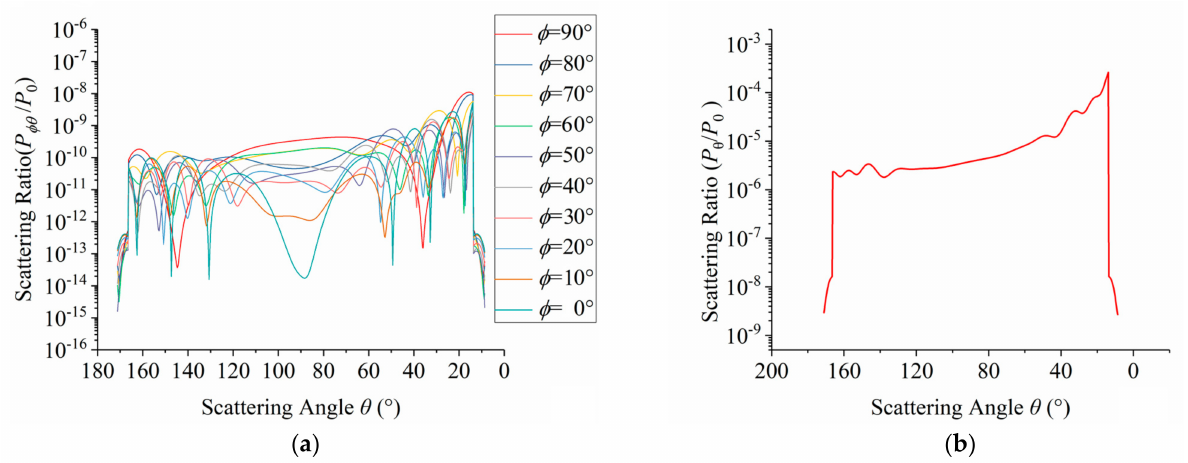
Figure 2. ( a ) The scattering ratio distribution P( θ , φ )/P 0 at different azimuth angles and ( b ) the total scattering ratio distribution P( θ )/P 0